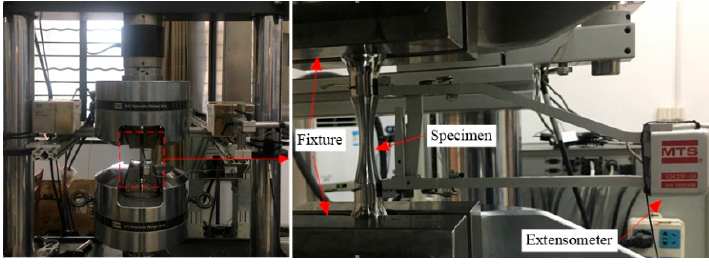
Figure 3. Test setup of notched specimen.